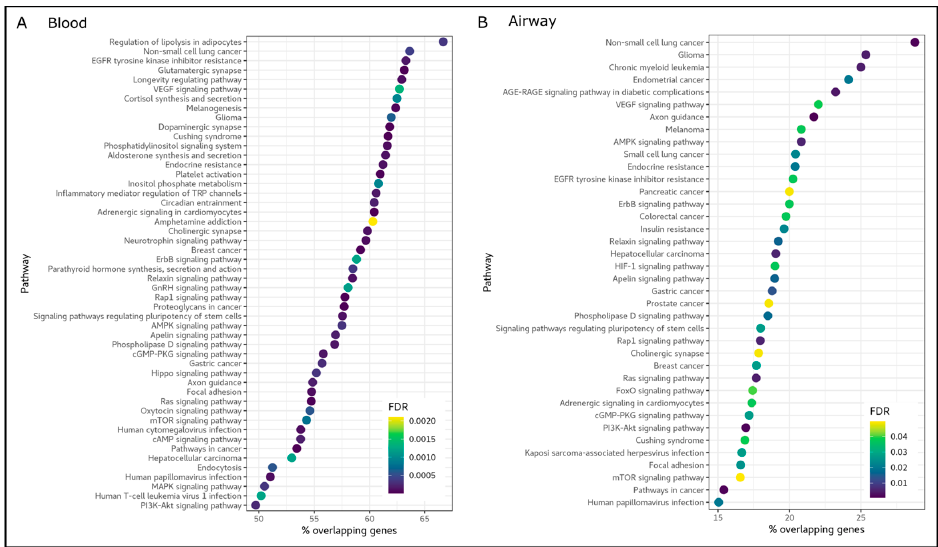
Figure 2. KEGG pathways enriched for differentially methylated genes for total SGRQ score. Hori- zontal and vertical axis represent the percentage of genes within each pathway that are characterized by differential methylation and description of the pathways, respectively. ( A ) Blood. ( B ) Air- way. Table 2. Top five blood and airway DMPs for SGRQ scores. SGRQ Tissue Score